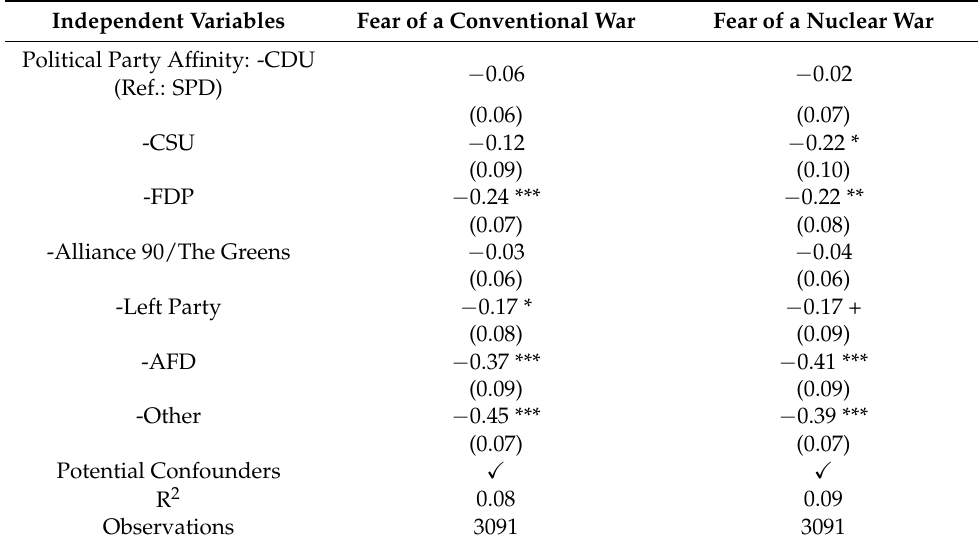
Table 3. Political party affinity and fear of war (both continuously). Results of multiple linear regressions. Independent Variables Fear of a Conventional War Fear of a Nuclear